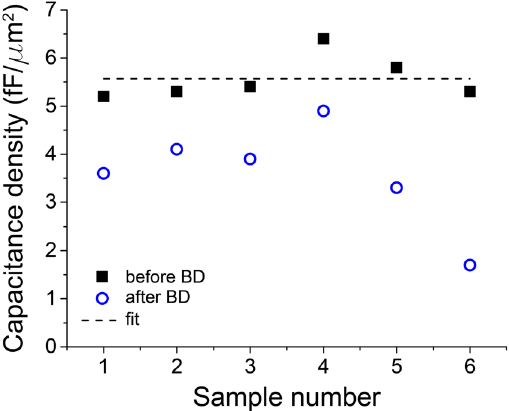
Figure 5. The capacitance of the samples before (black squares) and after (blue circles) the initial global breakdown. The thickness of the dielectric is 6.5 nm. Dashed line depicts the average value of the capacitance obtained before breakdown.